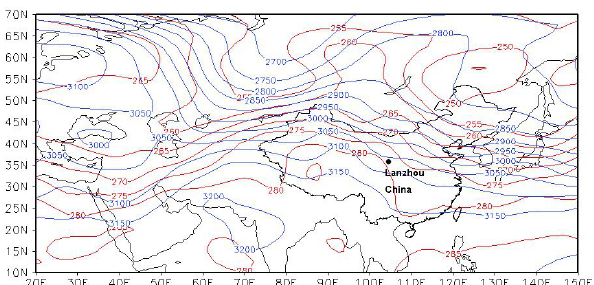
Fig. 2. Distributions of 700 hPa geopotential height and potential temperature at 14:00 (Beijing Time), 28 March 2007. A cold low trough appeared over the west Siberia to the Aral Sea and the Caspian Sea. China was located in front of the cold low trough and the SACOL in the northwest current during the dust storm.